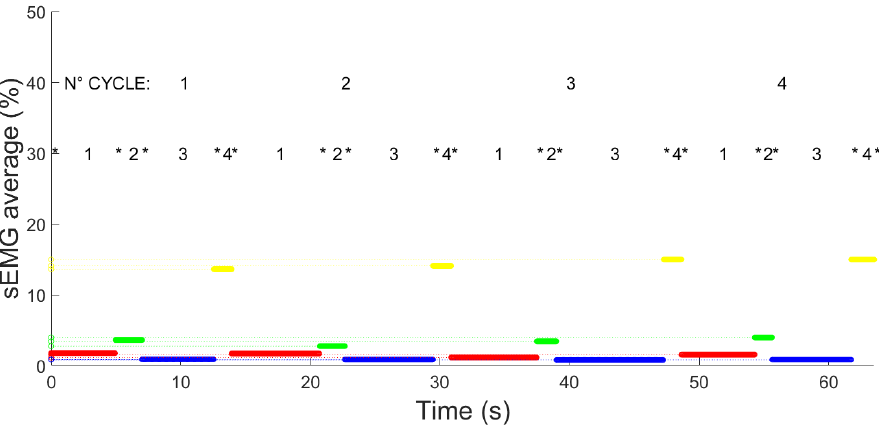
Figure 6. sEMG filtered and rectified is normalized respect the max value of each cycle and the average sEMG levels, for each phase of each muscle, are expressed in percentage. Each phase is represented by a different colour: standing phase (red), flexion phase (green), full-flexion phase (blue), extension phase (yellow). They are referred to the same healthy subject of the previous